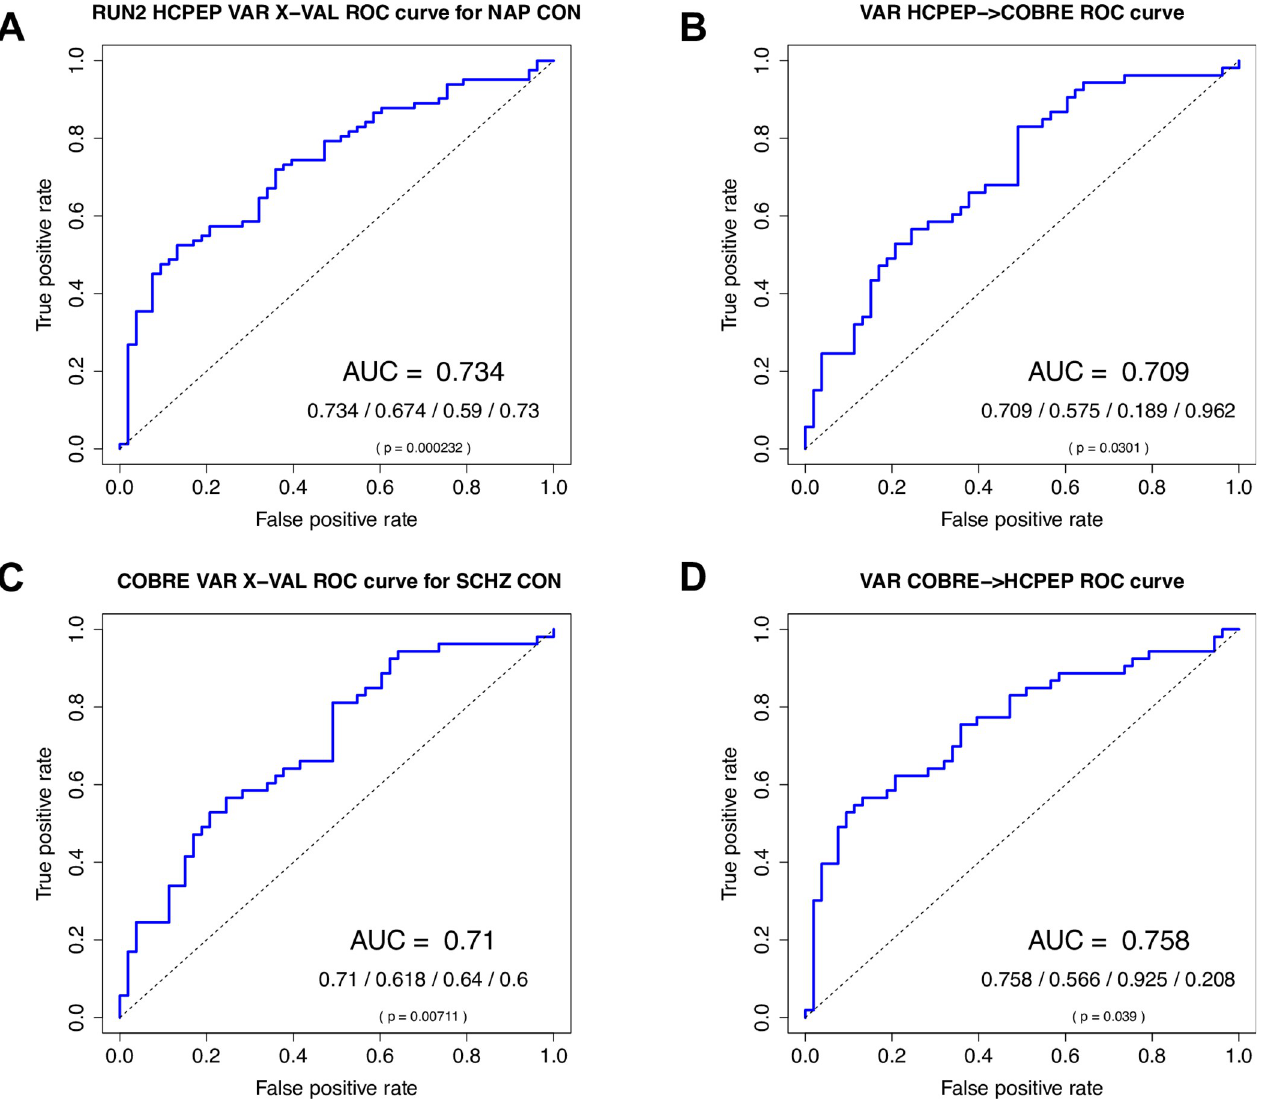
Fig 6. na ï ve Bayes classifier results for discriminating cases from controls using a single a-priori feature VAR in Mode ψ 4 . A) Results for HCPEP model trained and cross-validated in RUN2. B) Results for HCPEP model trained and cross-validated in RUN2 and tested in Cobre. C) Results for Cobre model trained and cross-validated. D) Results for Cobre model trained and cross-validated in Cobre and tested in HCPEP RUN2. AUC/Balanced accuracy/ Sensitivity/Specificity; p value calculated from the binomial distribution. AUC, area under receiver operating characteristic